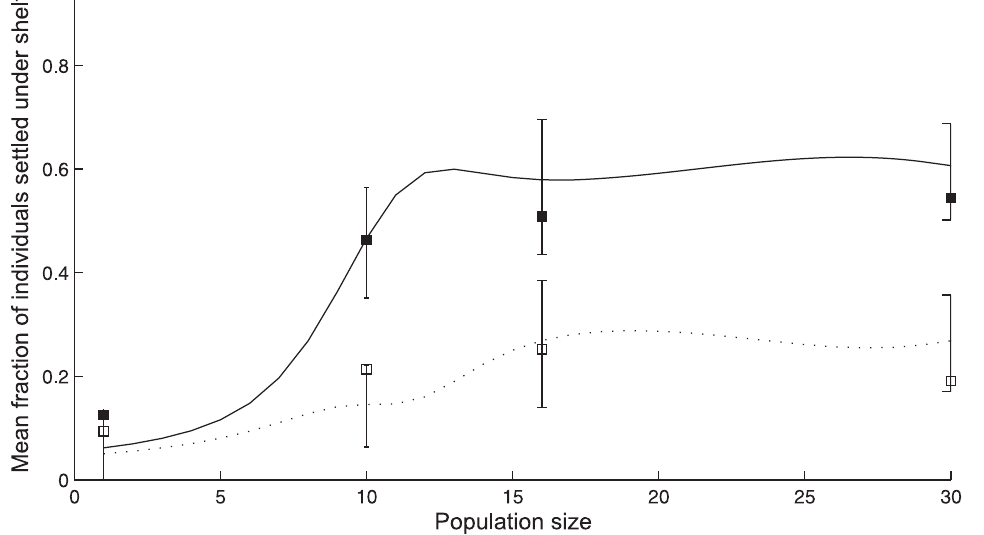
Figure 3. Theoretical and experimental discrimination efficiency. The resolution of the numerical equation gives the mean fraction of individual settled under the dark (solid line) and the light (dashed line) shelter for population size varying between 1 and 30 individuals ( h D =0.22, h L =0.27). Only for values corresponding to experimental population (1, 10, 16 and 30 individuals), we draw the confidence intervals (vertical lines) containing 95% of the mean theoretical results for groups of n experimental replicates (see statistical analysis section). The experimental results (full squares for dark and open squares for light) fall within the confidence intervals of the theoretical data.